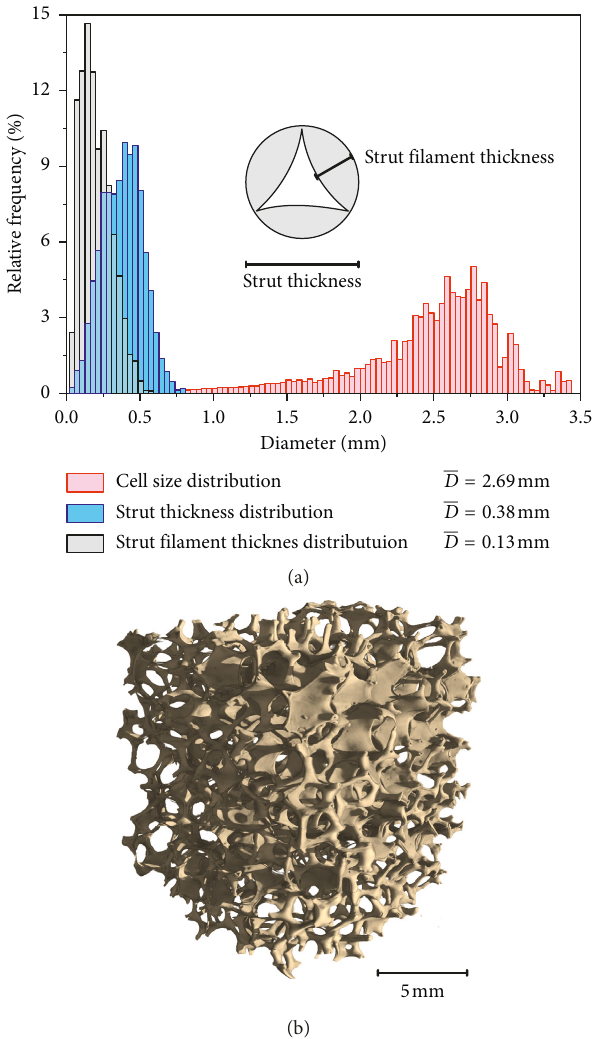
Figure 6: (a) Strut thickness and cell size distributions calculated from a three-dimensional μ -CT reconstruction of a 20 ppi ZnO ceramic foam; (b) three-dimensional reconstruction of the same ZnO foam.